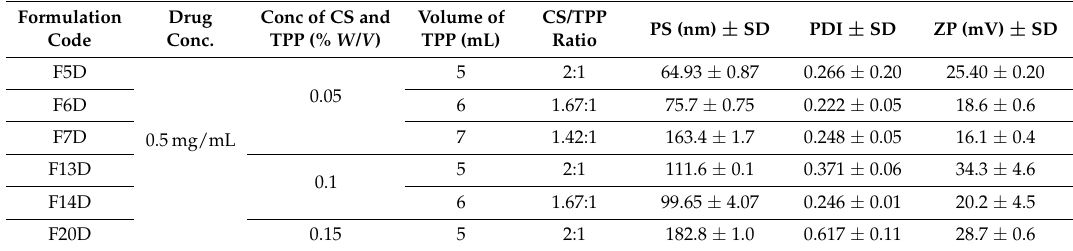
Table 1. Effect of CS and TPP concentration on particle size, polydispersity index, and zeta potential after addition of fixed concentration of drug ( n = 3).